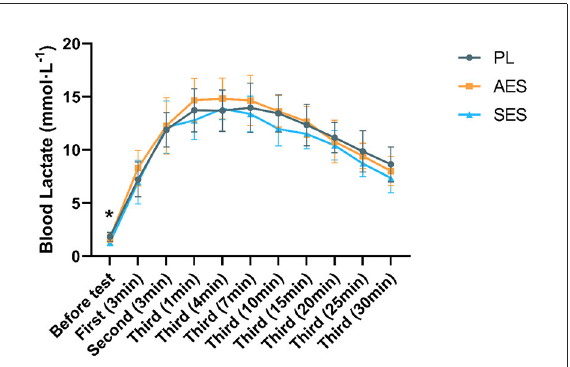
FIGURE4 Blood lactate concentration for exercise tests. Values are means ± SD. *Indicates a significant difference between the serial enteric-coated group and the placebo group ( p < 0.05). First (N min): N minute following the first WAT; Second (N min): N minute following the second WAT; Third (N min): N minute following the third WAT.